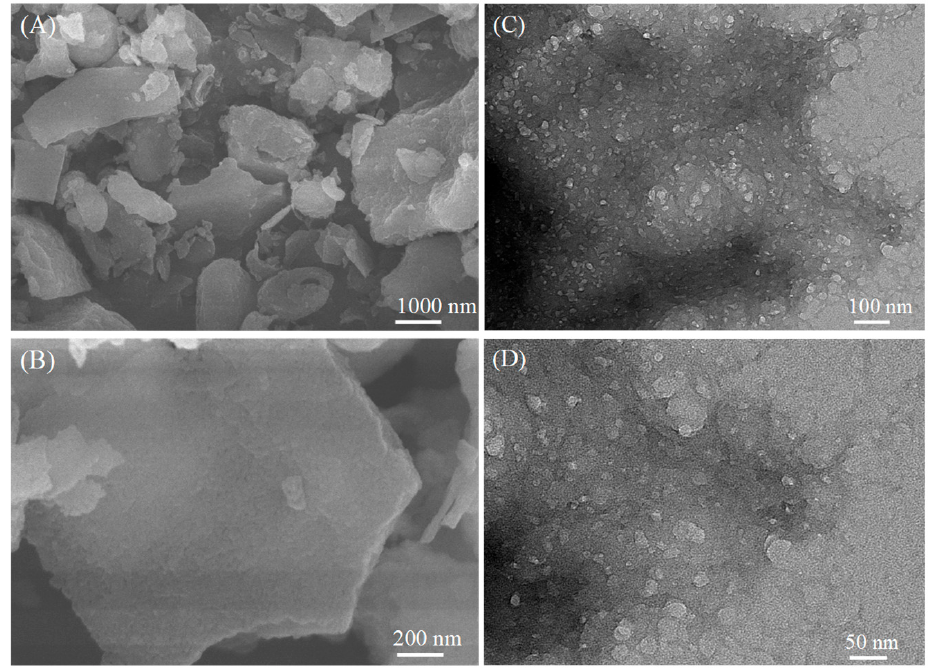
Figure 1. Morphology characterizations of PAA sponge: ( A , B ) SEM and ( C , D ) TEM images.